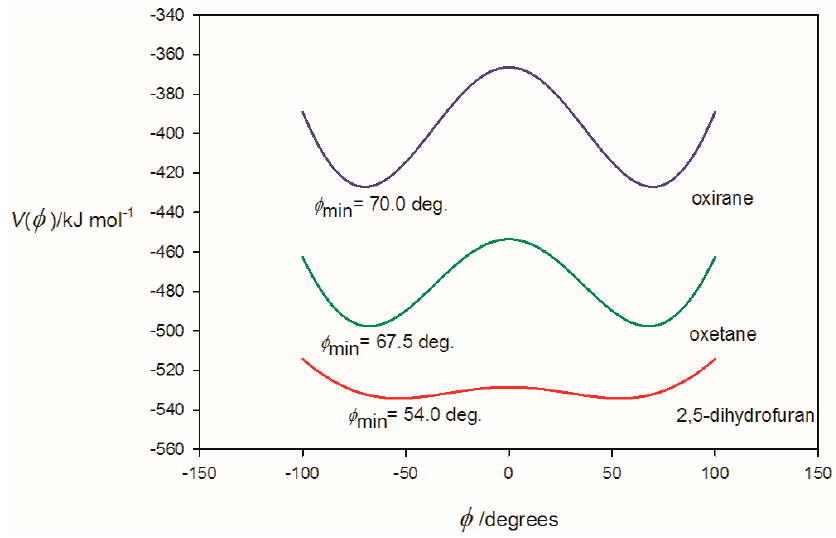
Figure 9. Variation of the electrostatic potential V ( φ ) with angle φ at a distance r = 1.6 Å from the O atom in each of 2,5-dihydrofuran, oxetane and oxirane when the multipoles on all atoms but oxygen are set to